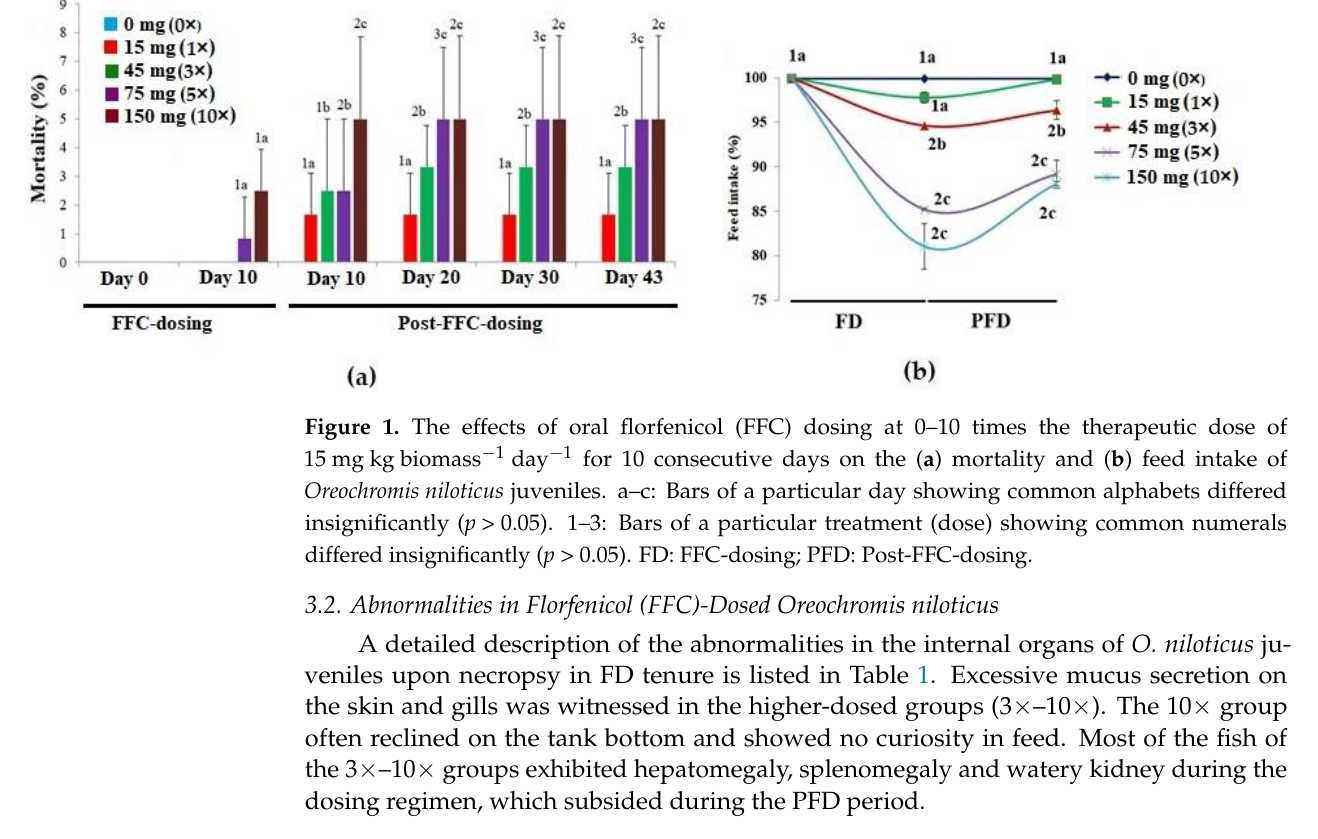
Table 1. Recorded abnormalities in Oreochromis niloticus juveniles after dietary florfenicol